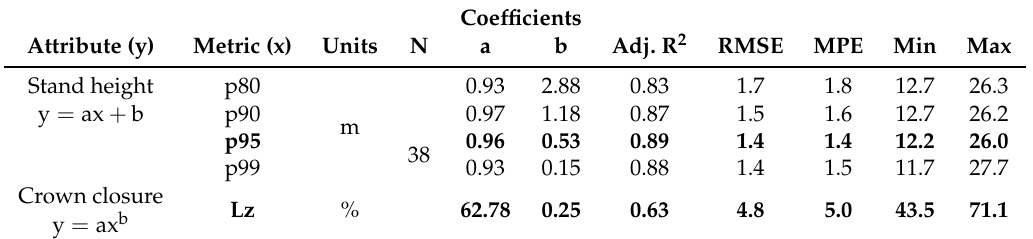
Table 3. Resulting model coefficients and fit statistics for testing areal LiDAR height metrics and Lz metric against field plot stand height and crown closure equivalents. P95 was determined as optimal as it exhibits most favourable Adj. R 2 , RMSE, and MPE. Implemented models are bold. Note, min and max are the minimum and maximum model predictive ranges, respectively.